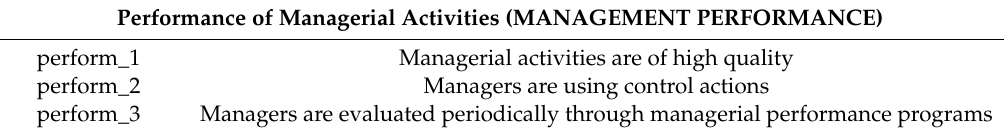
Table 2. Construction of reflective variables (dependent